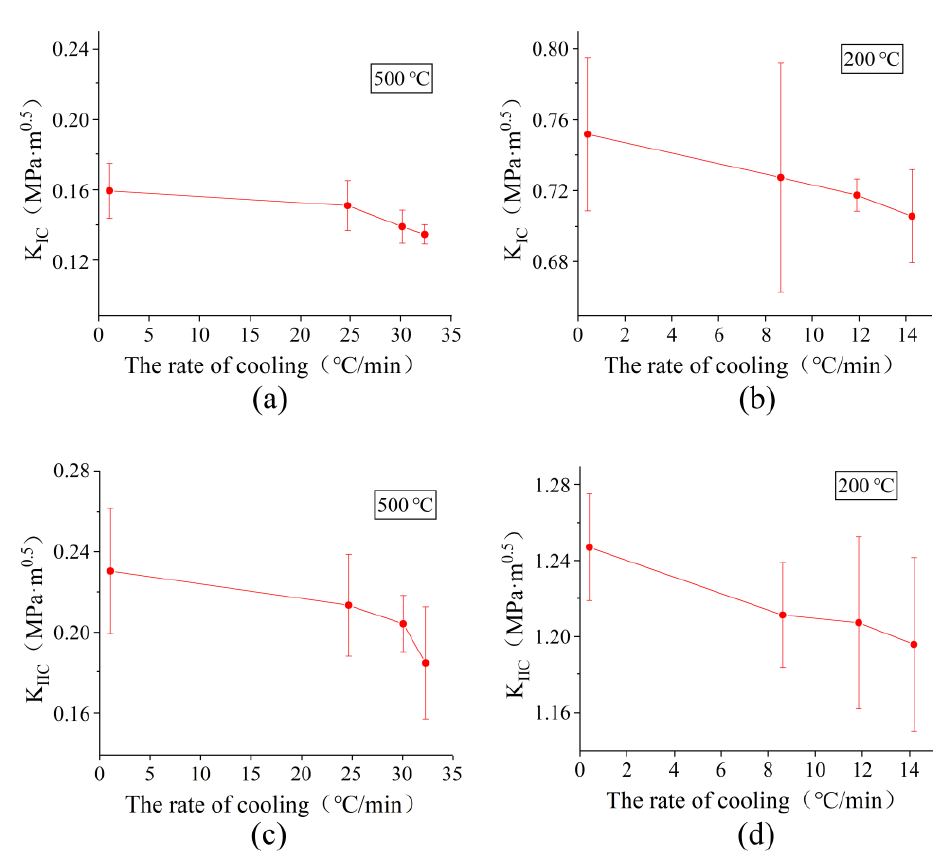
Figure 10. Fracture toughness of granite samples at different cooling rates: ( a , c ): heated at 500 °C; ( b , d ): heated at 200 °C (error bars denote standard deviation).